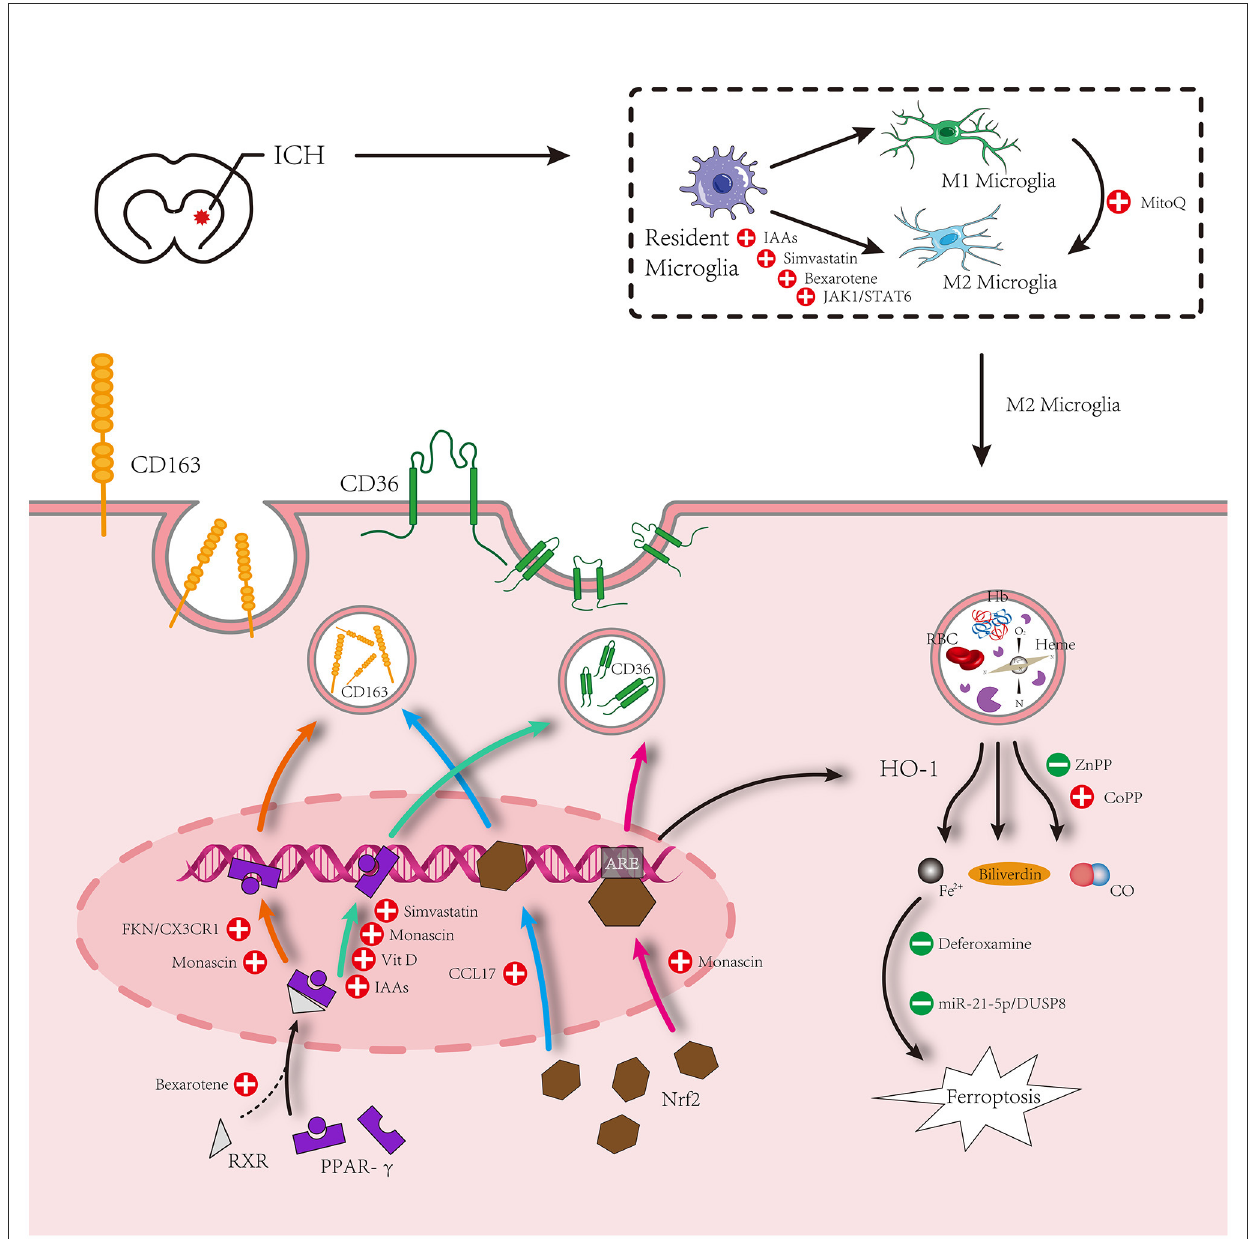
FIGURE2 Microglia surrounding hematomas after intracerebral hemorrhage are polarized to an M1 or M2 phenotype. M1 phenotype promotes inflammation. M2 inhibits inflammation and promotes phagocytosis. The hematoma component is engulfed by M2 microglia, which mainly increases the expression of proteins related to phagocytosis under the action of PPAR- γ and Nrf2 signaling pathways and relieves the cytotoxicity of metabolites after phagocytosis of hematoma components. Simultaneously, M1 is inhibited by some other drugs to promote the polarization of M2